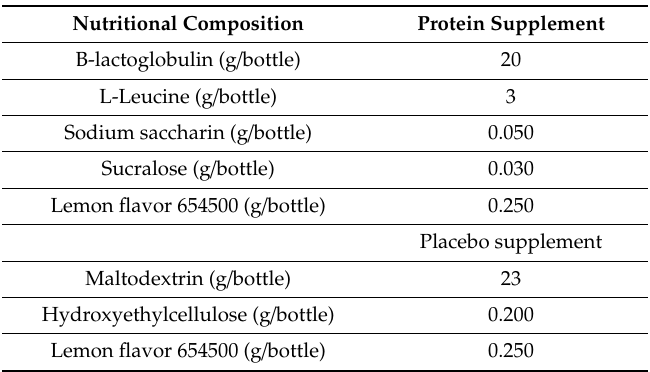
Table 1. Nutritional composition of the protein and placebo